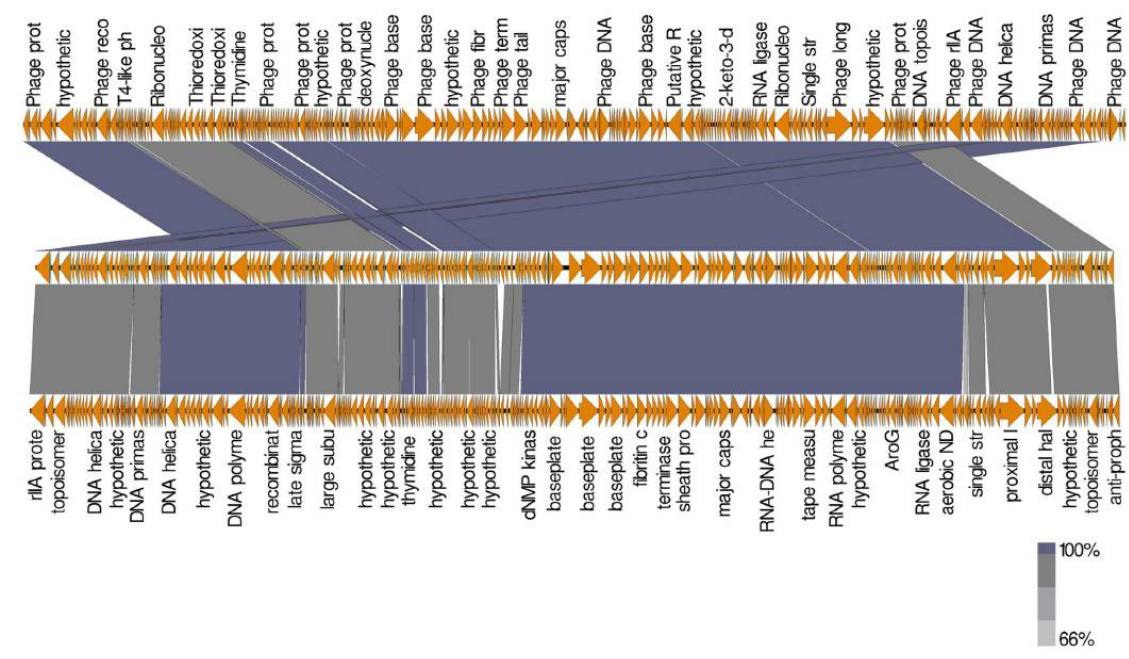
Figure 12. Comparison of ORFs between Escherichia phage ST2 ( above ) and the most closed phages Escherichia phage vB EcoM PhAPEC2 ( middle ) and Shigella phage Shf125875 ( below ). Analysis was performed using EasyFig software version 2.2.5. HP, hypothetical protein. Table 6. Genes occurred in Escherichia phage ST2 and not present in Escherichia phage vB EcomM PhAPEC2.